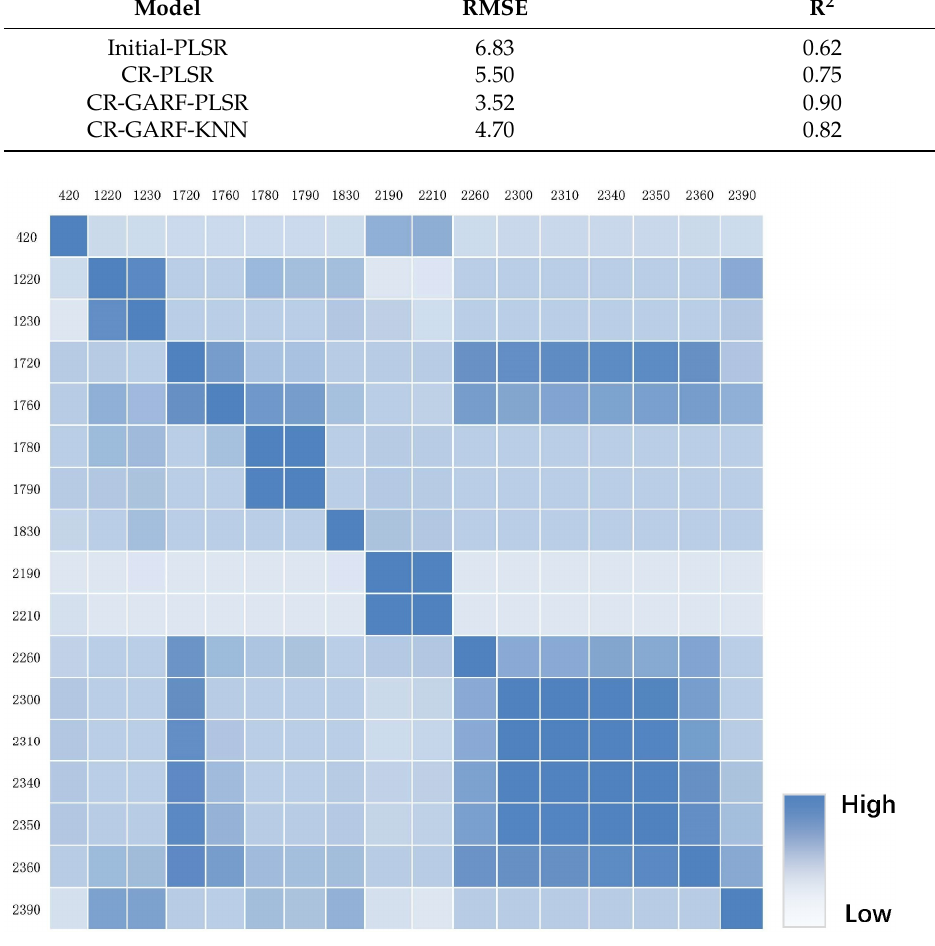
Figure 8. Heatmap of the correlation coefficient of CR-GARF optimal characteristic bands (wave- length/nm).